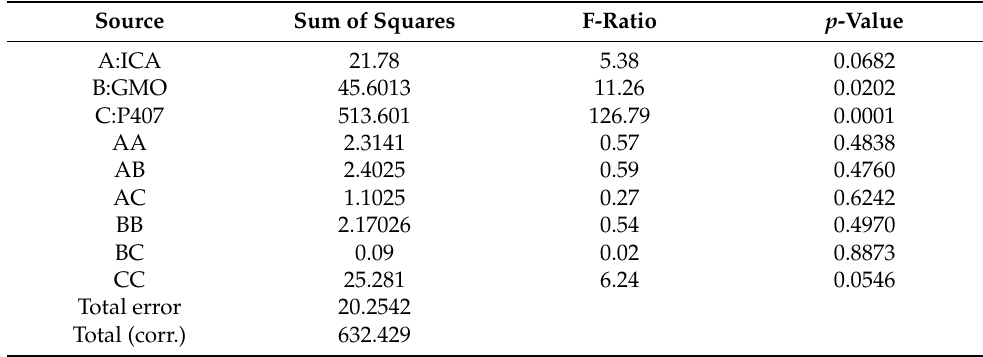
Table 3. Analysis of variance data for entrapment efficiency.